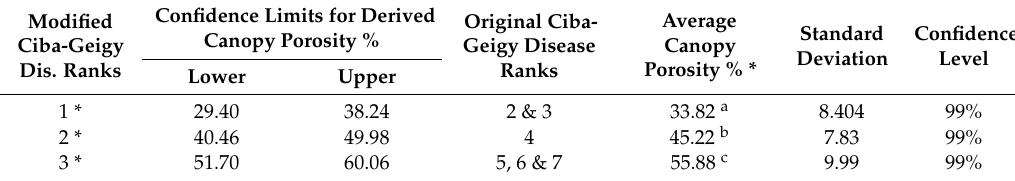
Table 3. Confidence limits for porosity values with modified Ciba-Geigy disease ranks.